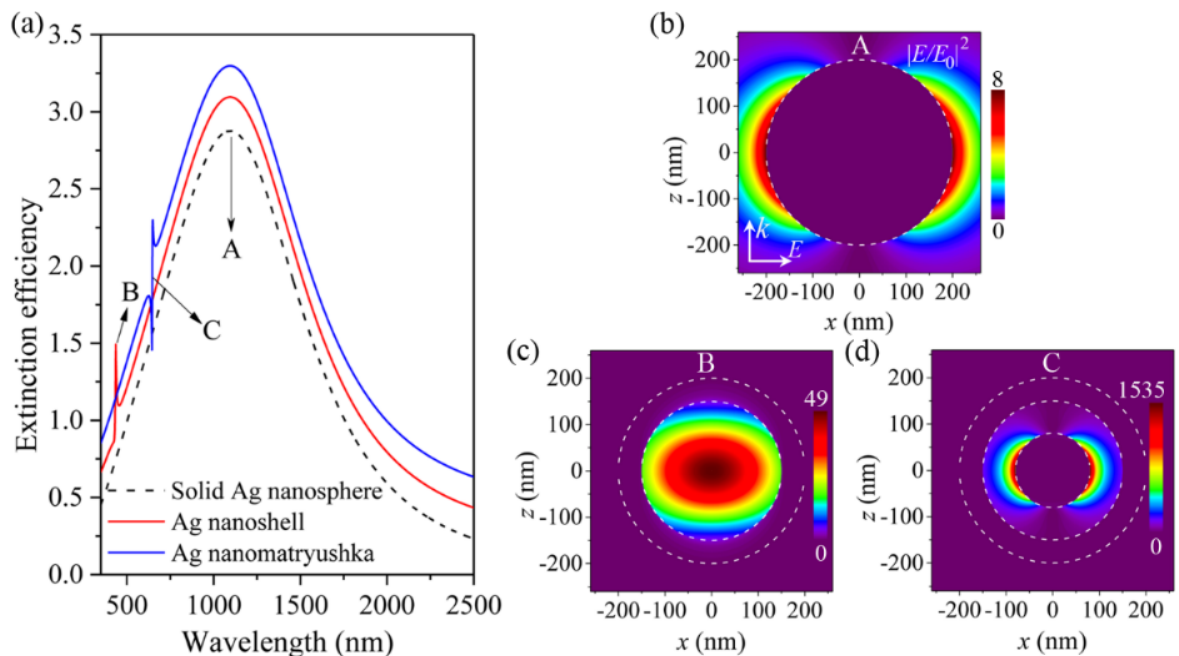
Figure 2. ( a ) Calculated extinction efficiency spectra ( a 1 ) for a solid Ag nanosphere ( r = 200 nm, black dash line), an Ag nanoshell ( r core1 = 150 nm, n core1 = 1.0, red line) and an Ag nanomatryushka ( r core2 = 80 nm, d = 70 nm, n d = 1.0, blue line), respectively (each spectrum vertically offset by 0.2 for clarity). ( b – d ) Electric field intensity distributions at k-E plane for resonances A, B, C in ( a ), respectively.